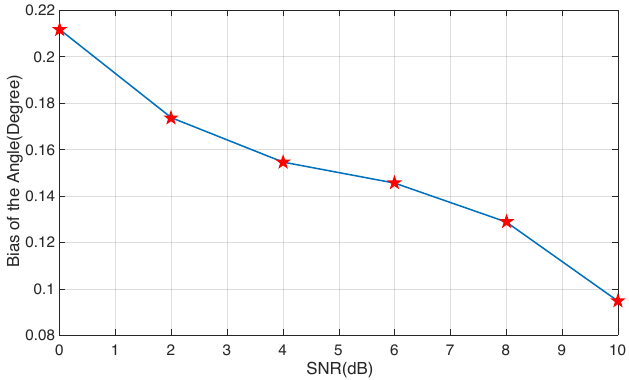
Figure 6. The DoA and DoD estimation